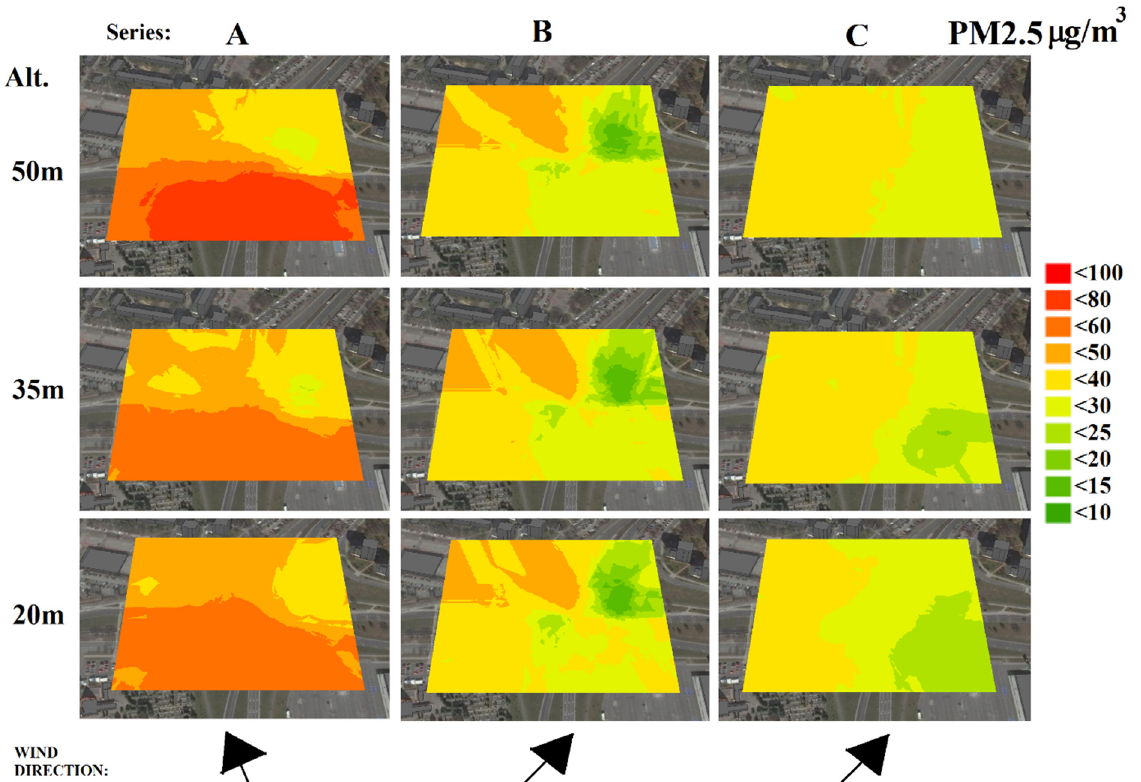
Figure 10. Spatial distribution of PM 2.5 pollution at the altitude of 20, 35 and 50 m for three measurement series in the area of the street intersection.